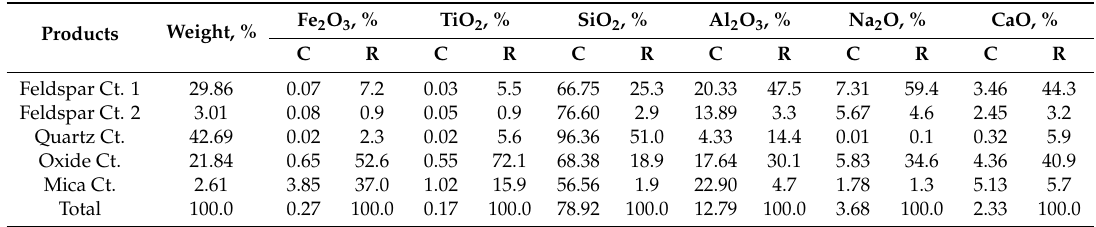
Table 4. The results of the optimized flotation test using hydrofluoric acid + sulfonates + 1000 g/t Na 2 SiO 3 . Products